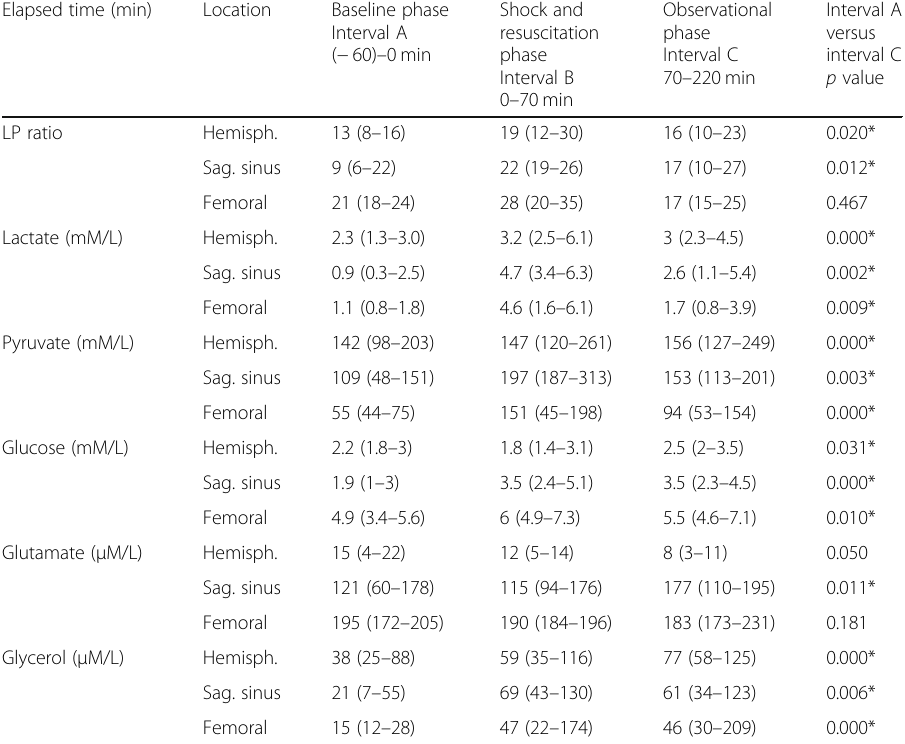
Table 2 Biochemical variables obtained from microdialysis. N = 9. Data expressed as (interquartile range) during the experimental protocol intervals A, B, and C. LP lactate/pyruvate ratio. S indicates start of hemorrhage. Time 0 indicates achievement of MAP equal 40 mmHg. Test statistics